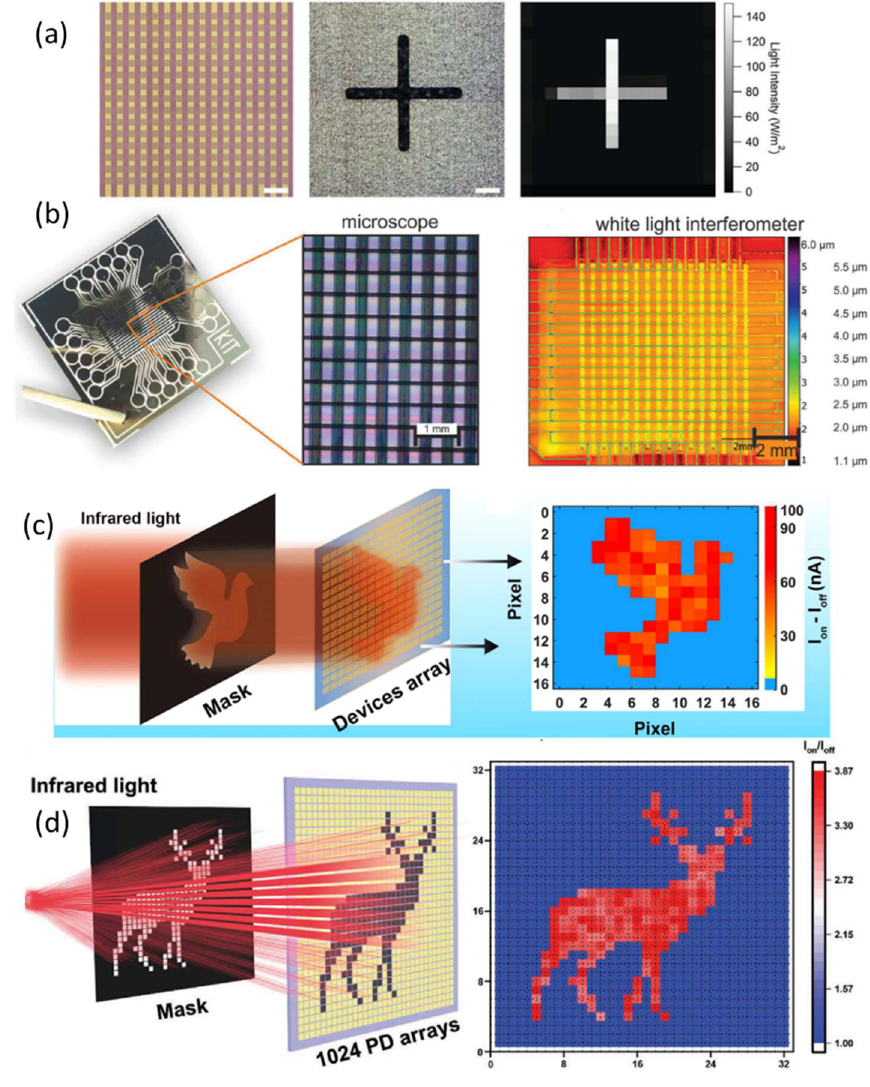
Figure 12. ( a ) Optical microscope image of a 16 × 16 (active area, 2.40 mm 2 ; pixel pitch, 50 µm, left panel) array on a glass substrate, Reprinted with permission from [168] ©2018 Wiley, ( b ) photograph, microscope image, and topographical image (white light interferometric microscope image) of the completed pixel array, reprinted with permission from [171] ©2018 Wiley, ( c ) schematic illustration of the image sensor irradiated by 1342 nm light and the corresponding output images of the bird by the flexible SWIR image sensor, reprinted with permission from [39] ©2020 Elsevier, and ( d ) schematic diagram of multi-pixel image sensor imaging and the deer pattern composed of 1024-pixel output by Ti 3 C 2 Tx-RAN PD image sensor reprinted with permission from [54] ©2022 Wiley .